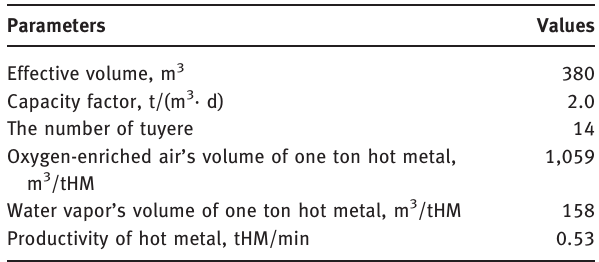
Table 2 lists the process parameters of oxygen blast furnace based on the actual conditions by simulation.